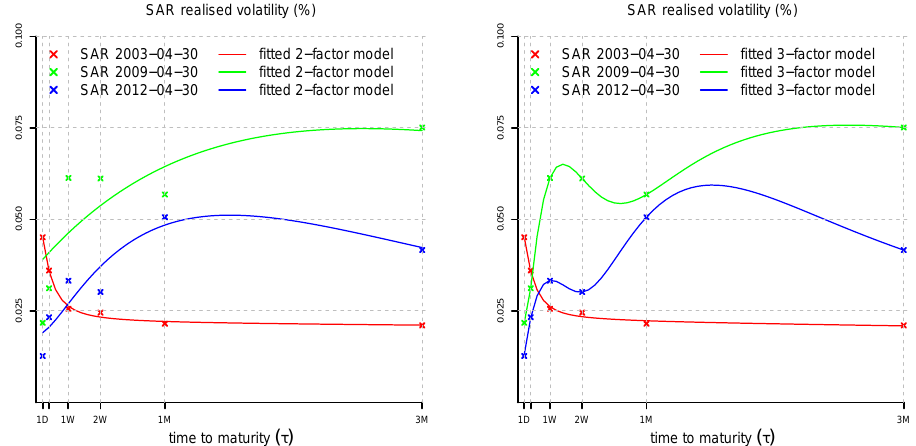
(cid:92) Figure 7. SAR realized volatility RCov ( t , τ , τ ) 1 2 for K = 126, τ = 1,2,5,10,21,63 and three observation dates compared to the realized volatility of the two- (lhs) and three-factor (rhs) Vasiˇcek model fitted by optimization (23) for M = 6, τ 1 = 1, τ 2 = 2, τ 3 = 5, τ 4 = 10, τ 5 = 21, τ 6 = 63 and w ij = 1 { i = j } . The three-factor model achieves an accurate fit.